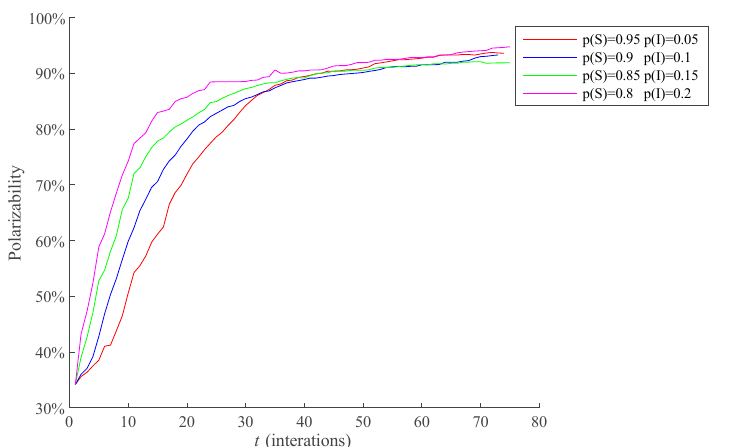
Figure 7. The influence of different proportion of communication individuals at the initial moment on the polarization process of public